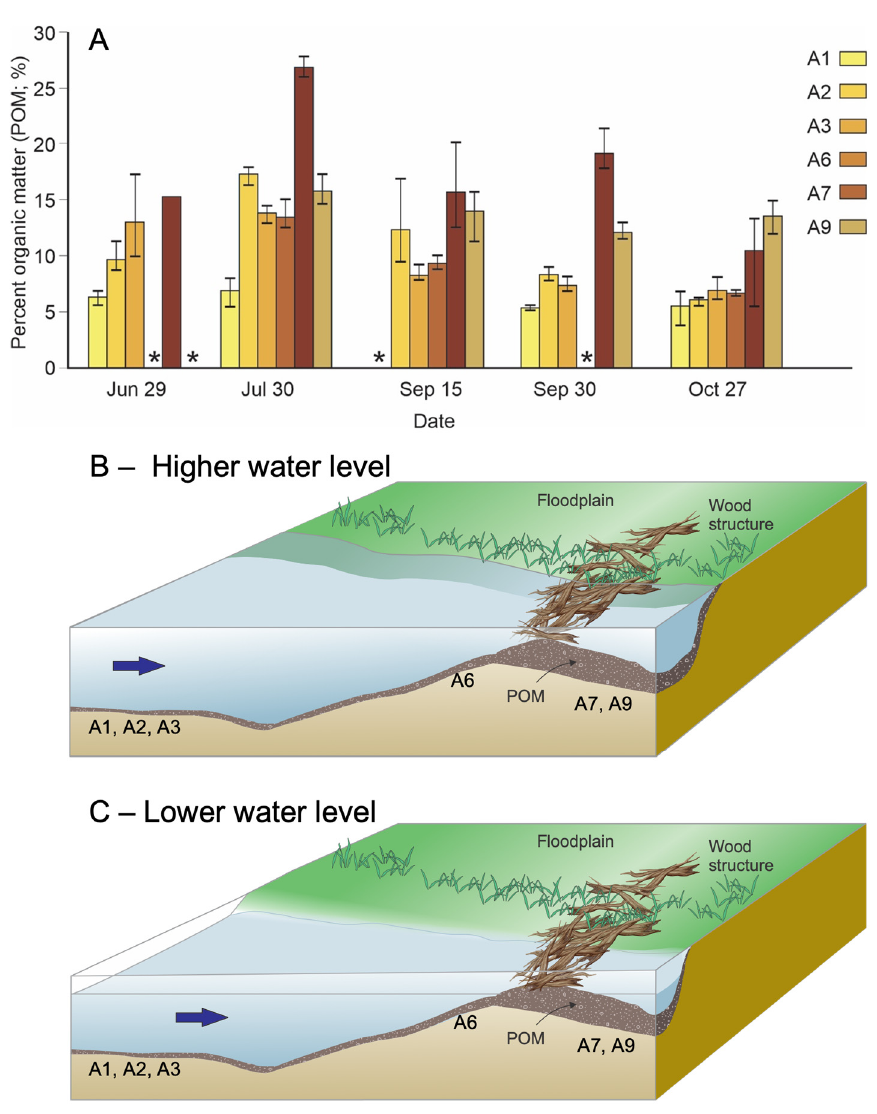
Figure 5. Percent organic matter (POM) in sediment samples taken from the bed at monitoring stations A1, A2, A3, A6, A7, and A9 throughout the 2020 field season ( A ). Error bars show POM range for each day sampled (three samples). Dates with an asterisk (*) indicate stations where no samples were retrieved. Schematic illustrations of the wood structures within the channel and corresponding (relative, not to scale) locations of the various stations for higher water levels ( B ) and lower water levels ( C ). Station A7 and A9 are immediately downstream of a wood structure and generally saw the highest amounts of stored organic material in the sediments sampled. A1 consistently had the lowest amounts, usually less than half of the amount observed at A7 or